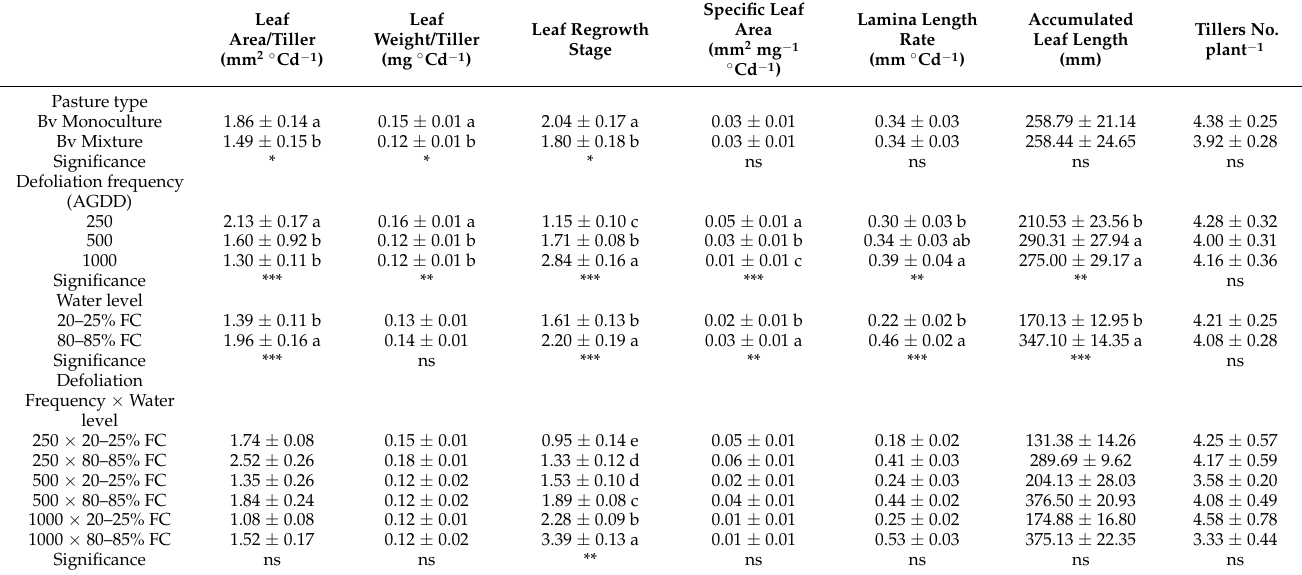
Table 1. Tiller components of Bromus valdivianus (Bv) grown under two pasture types (monoculture and in a 50/50% mixture with Lolium perenne ), and subjected to three levels of defoliation frequency (250, 500 and 1000 accumulated growing degree days (AGDD)), and two levels of soil water content (80–85% and 20–25% of field capacity (FC)). Values are presented as mean ±